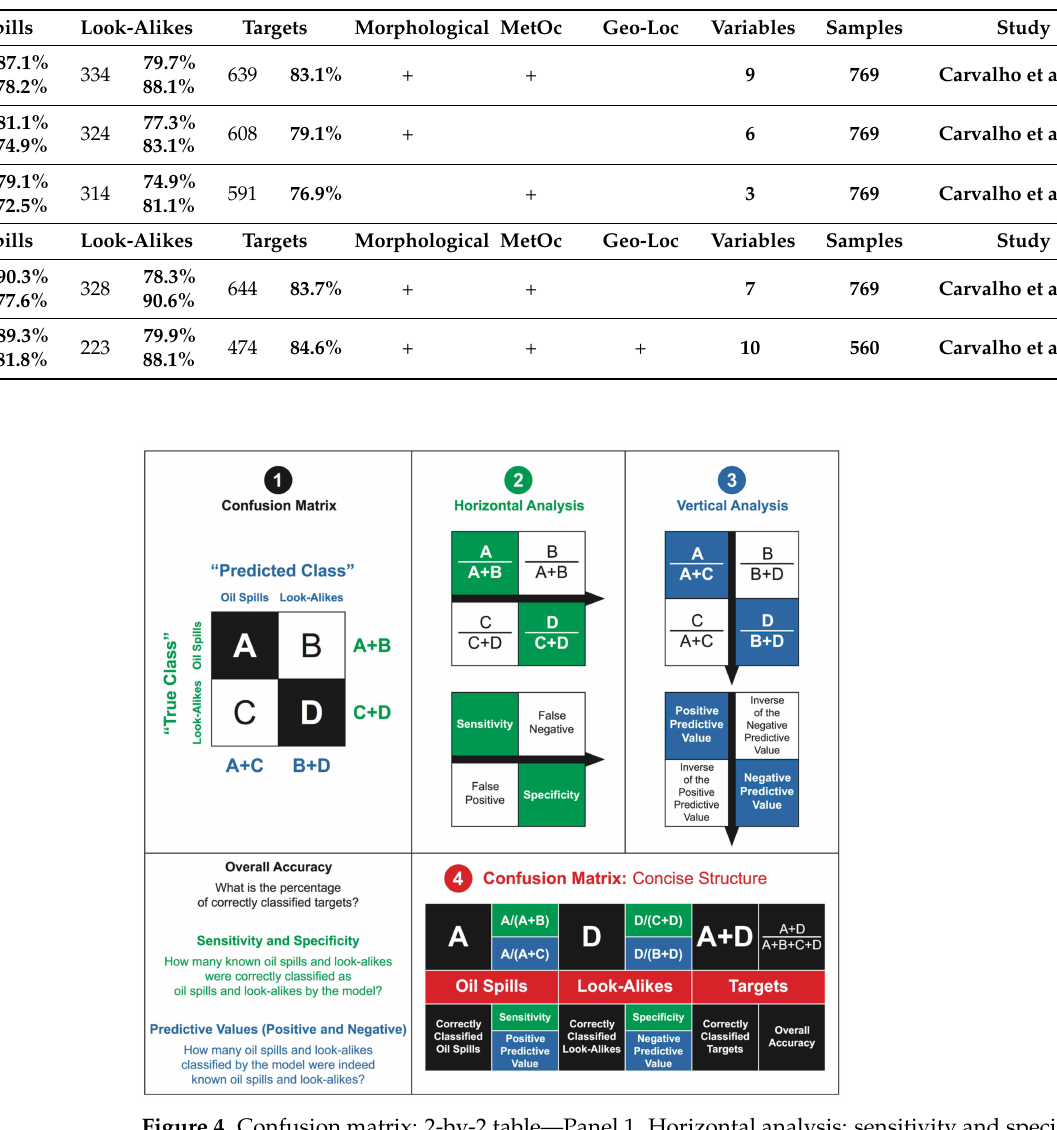
Table 1. Linear discriminant analysis (LDA) results from Carvalho et al. [31,32] that classified oil spills from look-alike slicks using the same database as the one used here (Section 2.2). These are used here as a benchmark to compare with the performance of six traditional machine-learning (ML) methods (Sections 2.4.2 and 2.4.3). Models LDA 1, 2, 3, 4, and 5 refer to their analyses without data transformation, so as to the use of different combinations of variables: morphological information, Meteorological and Oceanographic parameters (MetOc), and geo-location attributes (Geo-Loc). The symbol + indicates explored types of variables. See Figure 4 for information about overall accuracy, sensitivity, specificity, and predictive values (positive and negative). See Section 2.4.1.